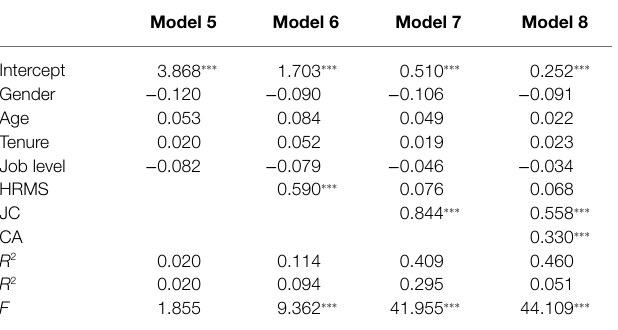
TABLE 7 | Main effect and mediating effect